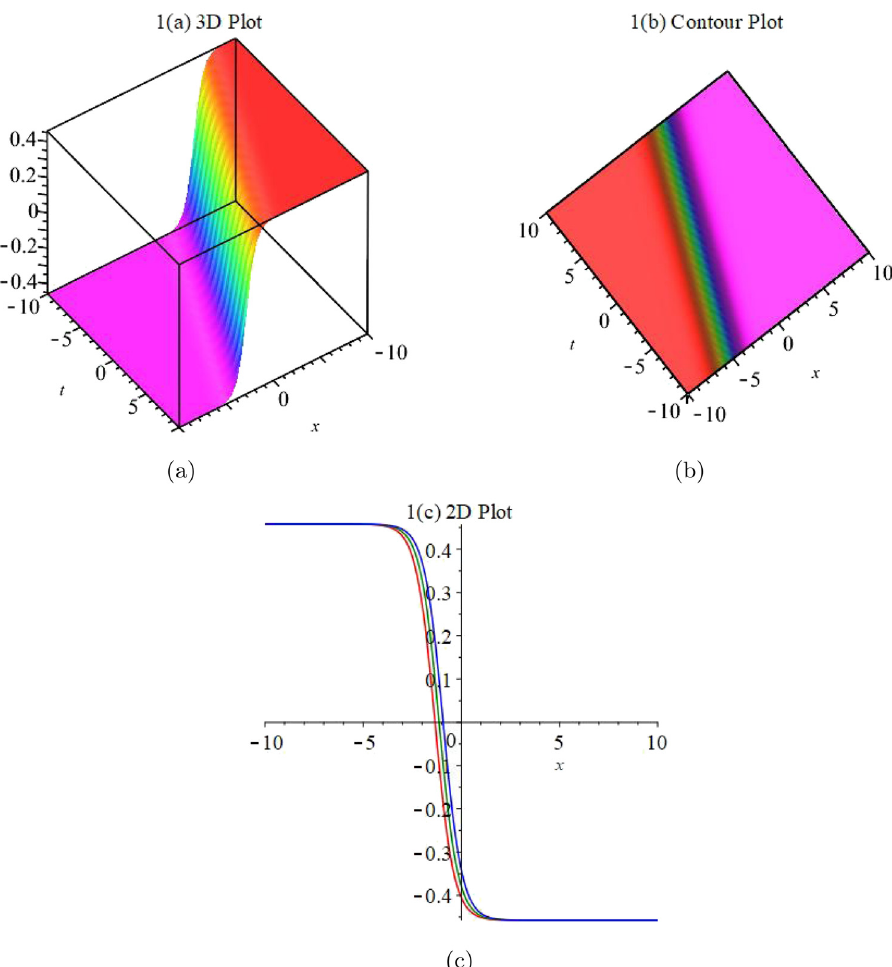
Figure 1: Graphical representations of ( a ) and ( b ) when